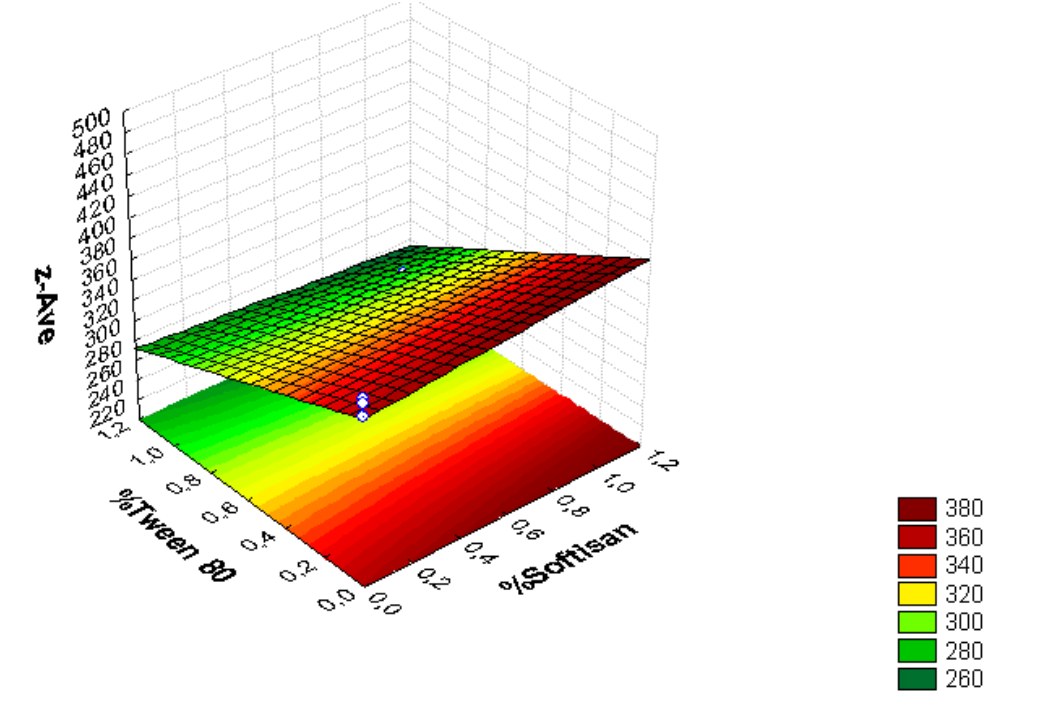
® 80 and SOFTISAN ® 649 on z-Ave.